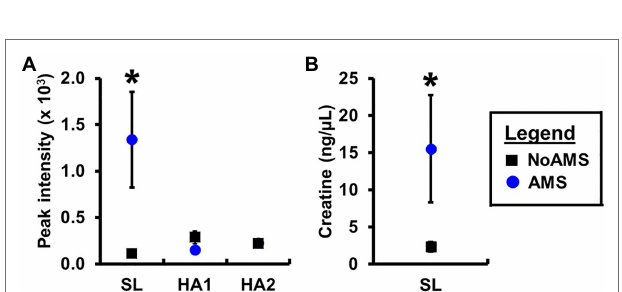
FIGURE 3 | Orthogonal projection onto latent structures – discriminant analysis (OPLS-DA; T-scores plot) modeling the urinary metabolite data for AMS (solid circle) vs. NoAMS (solid square) groups at SL. Data were autoscaled using all groups as reference. The analysis is highly significant with Q 2 = 1.0 ( p < 0.001).